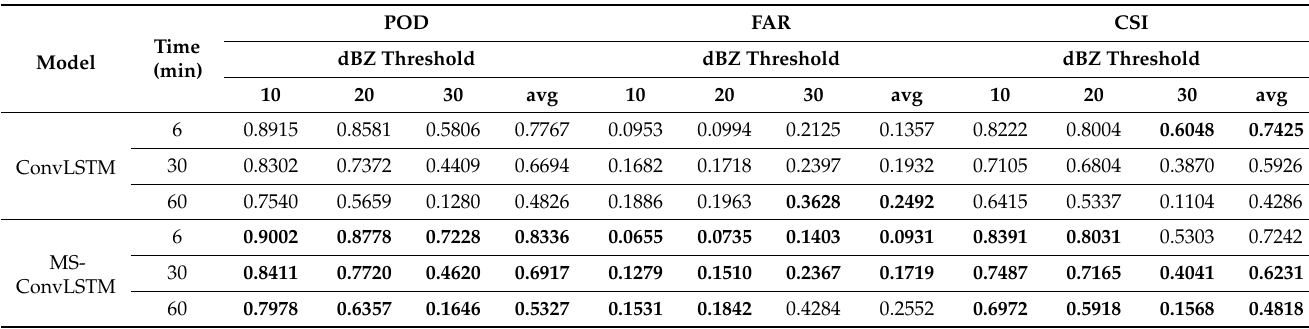
Table 2. The probability of detection (POD) values, false alarm rate (FAR) values, and critical success index (CSI) of the two models in test sample 1 at 6 min, 30 min, and 60 min. The best results are marked in bold .